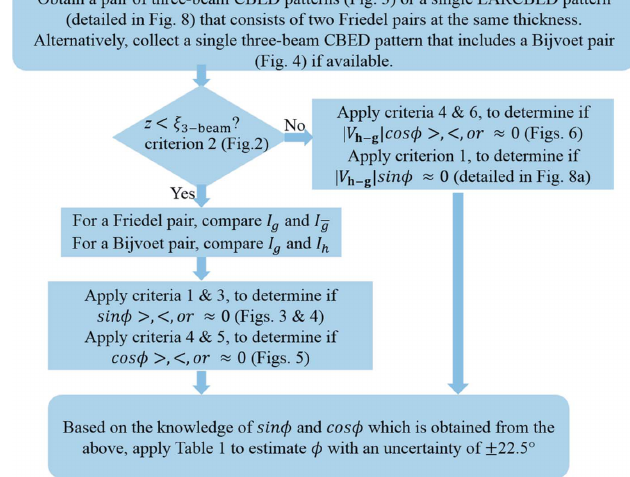
Figure 7 A flowchart that summarizes the procedures for determining the three-phase invariants from three-beam CBED